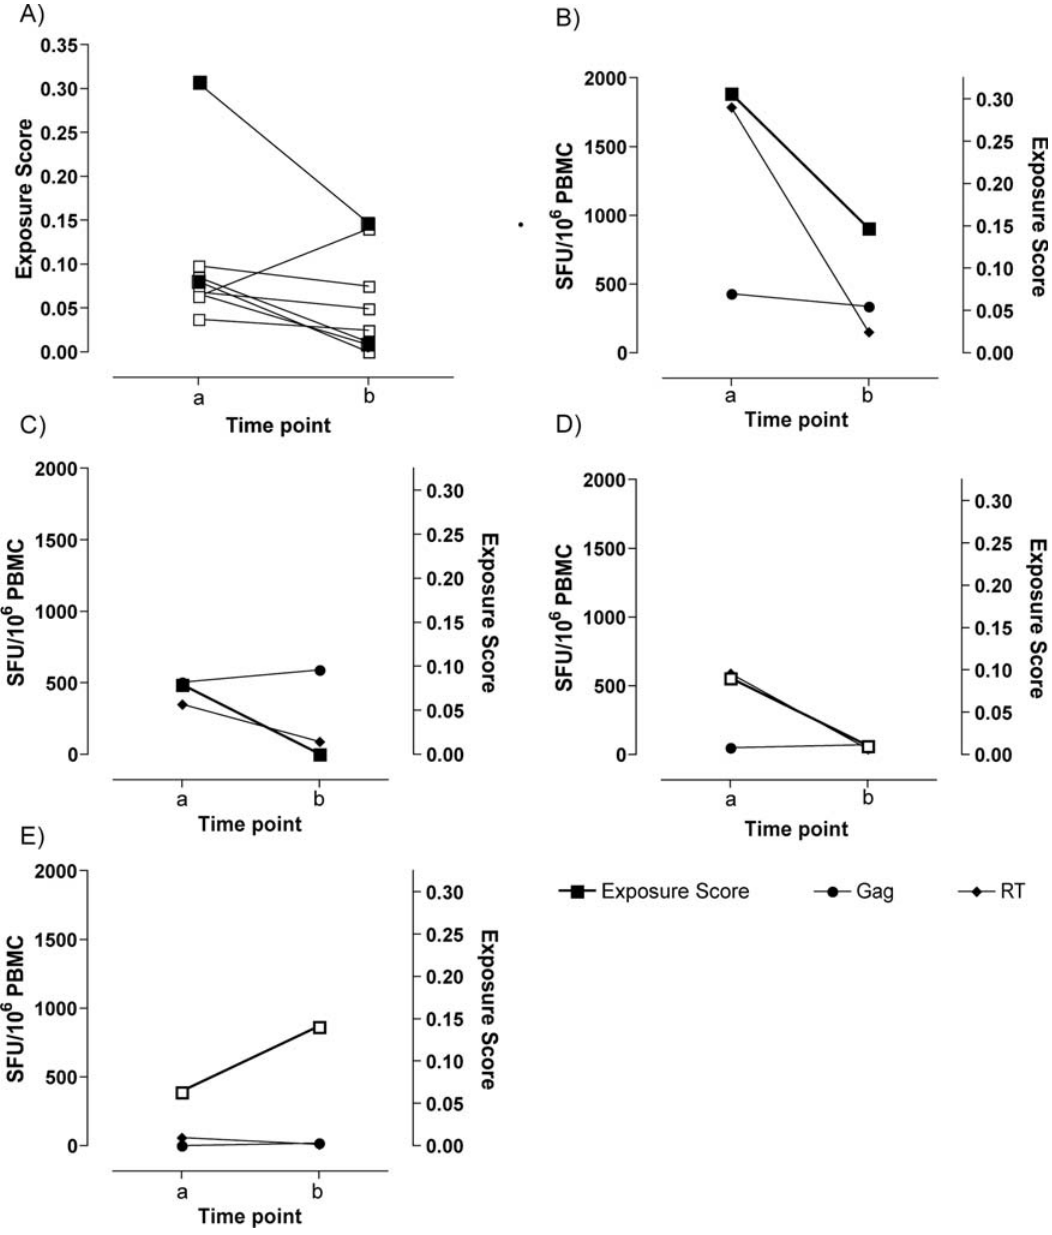
Figure 7. RT responses follow changes in exposure longitudinally. Exposure scores generated from questionnaires at the first time (time point 0) and 1 year later (time point 1) were compared for 7 individuals from the viremic partner group (A). Two individual’s partners started anti- retroviral therapy between the time points and their viral loads were below the level of detection at the second time point (filled squares). ELISpot technology was employed to measure IFN- c responses. Two individuals with aviremic partners at the second time point also showed a decrease in exposure to their partner (B and C), which was reflected in their anti-HIV-1 RT response. This was also seen in a third individual whose exposure dropped dramatically at the second time point (D). One individual showed an increase in their level of exposure, however, there was no responses was above background ( , 50 SFU) (E).